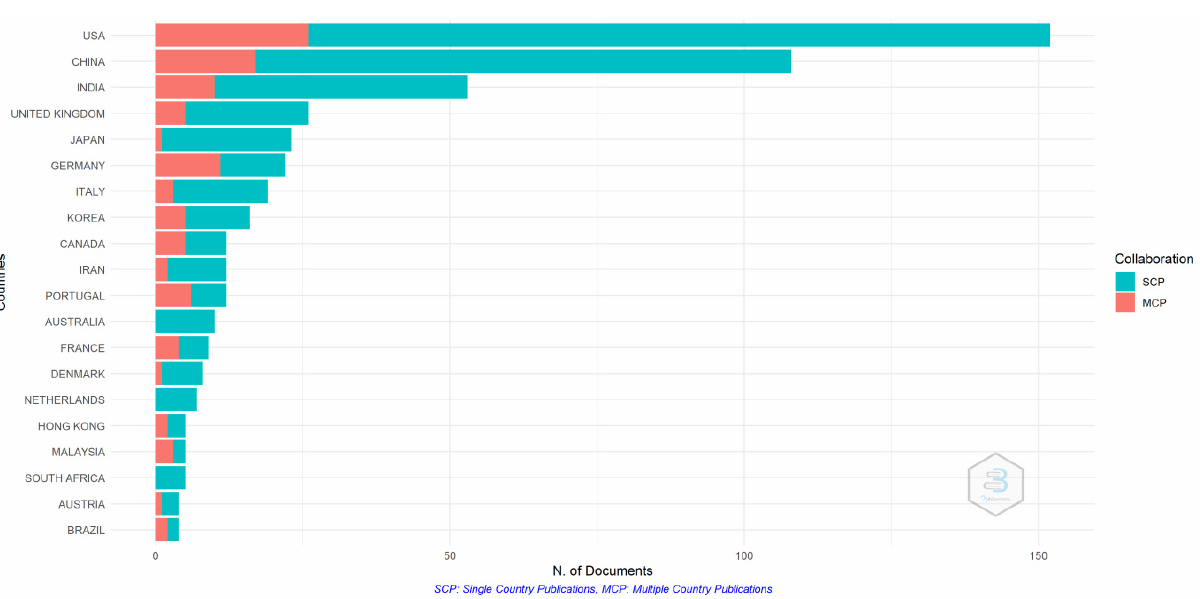
Figure 6. Selected author-specific publications. Source: Authors’ elaboration using the Bibliometrix R-package.